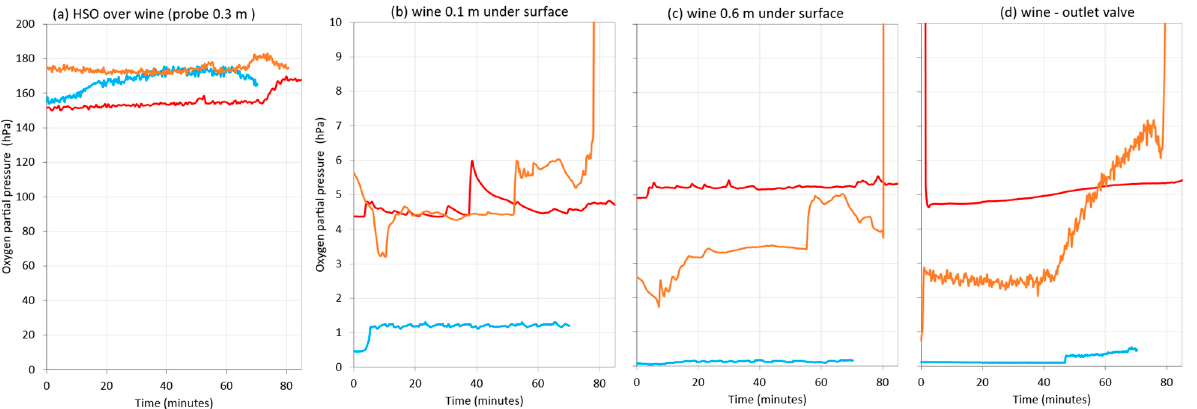
Figure 12. Comparison of oxygen content in the racked tank during wine racking in a commercial winery (Bodega Emina, Medina del Campo, Spain). Without inerting (red), using nitrogen as inerting gas (blue) or argon (orange) . Measures made in the atmosphere at 0.3 m above the surface of the wine ( a ); 0.1 m depth inside the wine ( b ); 0.6 m depth inside the wine ( c ) and wine at the outlet valve ( d ).